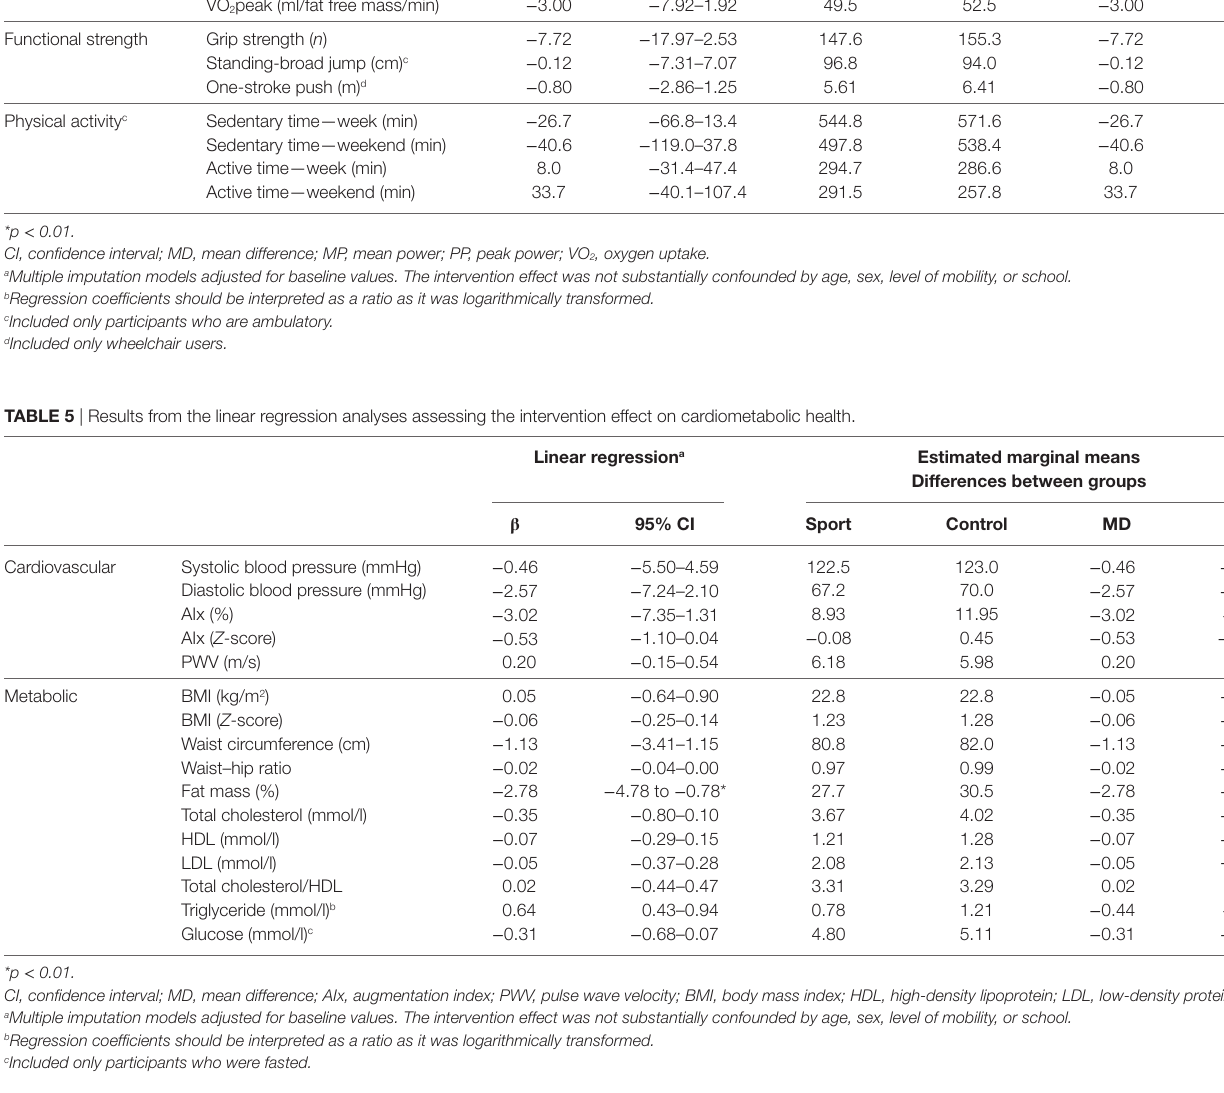
linear regression